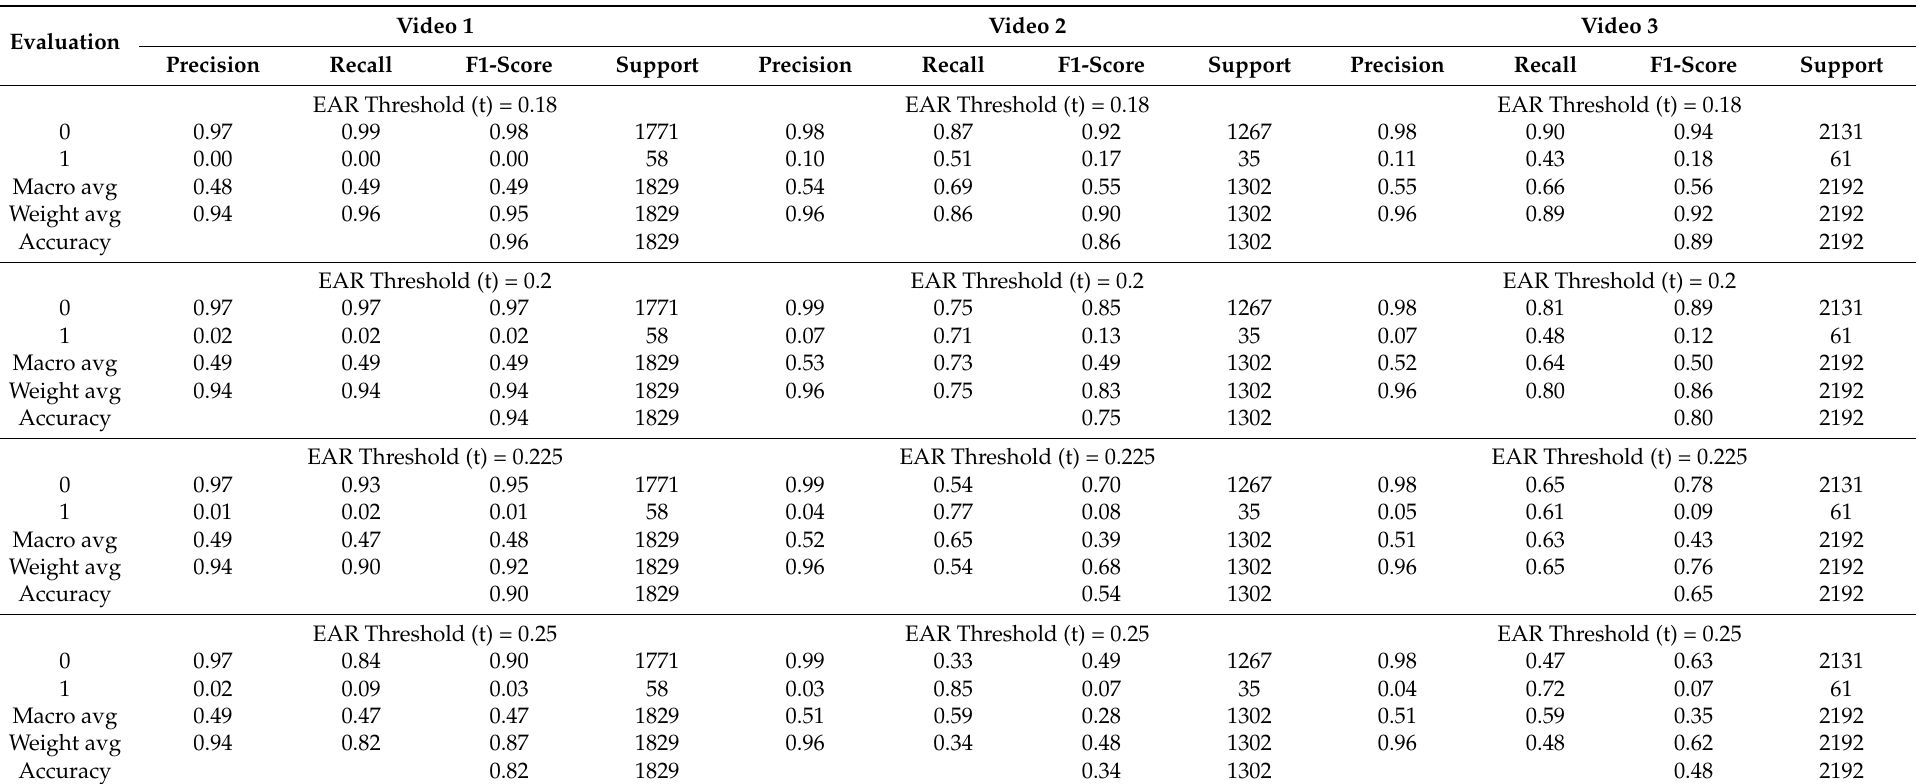
Table 5. Precision, recall, and F1-score (Eye Blink